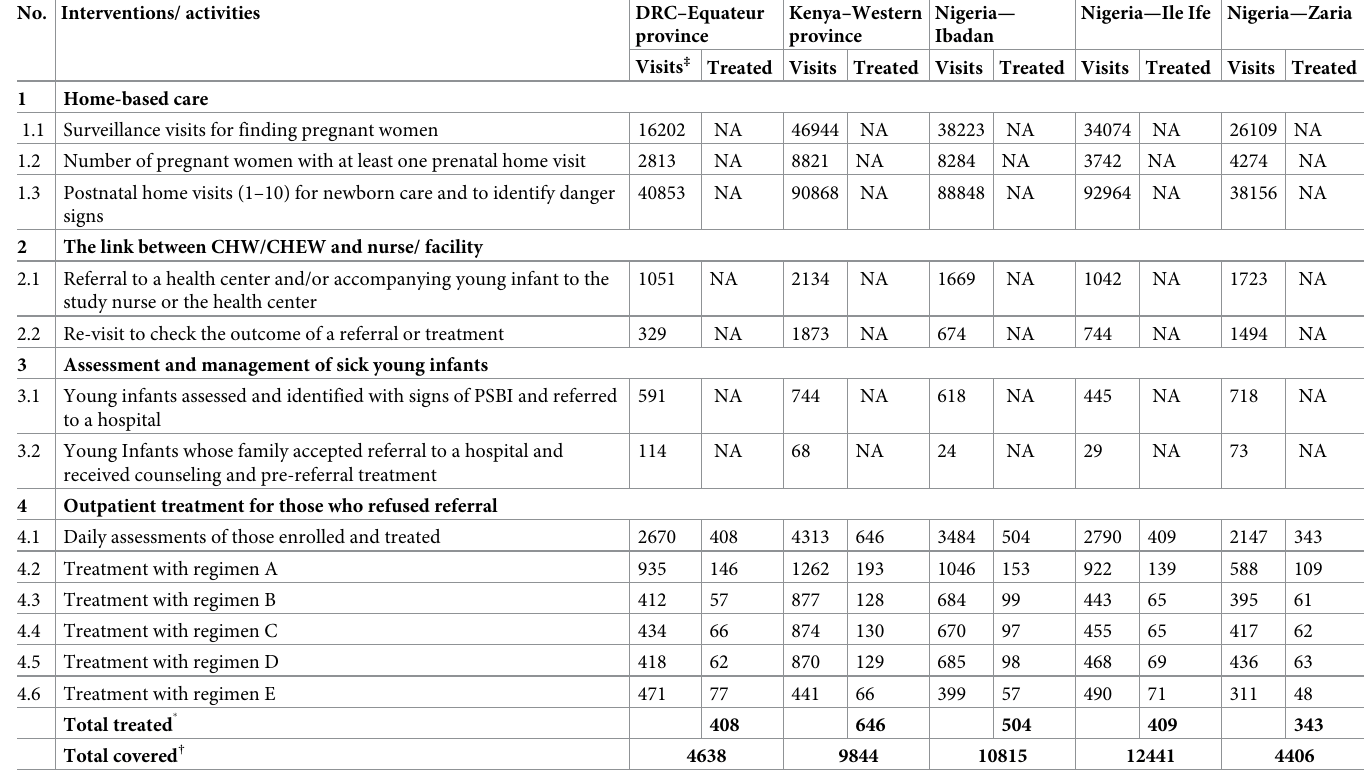
Table 2. Number of visits for each intervention and activity; the number of treated young infants under different regimens and the number of covered young infants at five sites in DRC, Kenya and Nigeria,